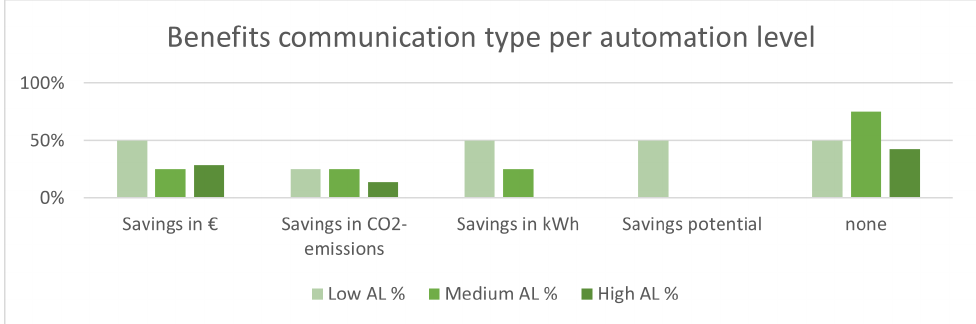
Figure 6. Benefit communication type per automation